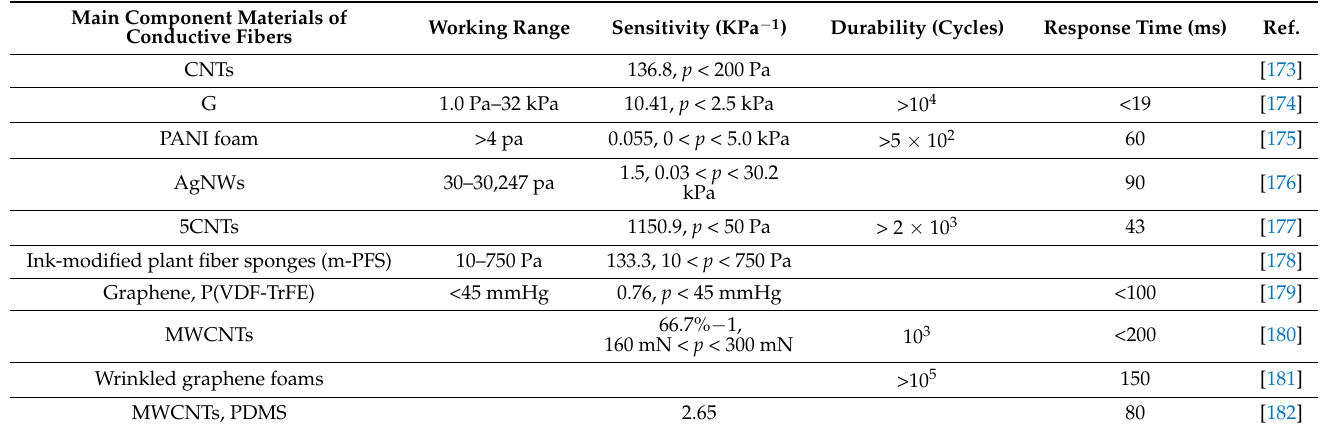
Table 3. Performance data sheets for some resistive pressure